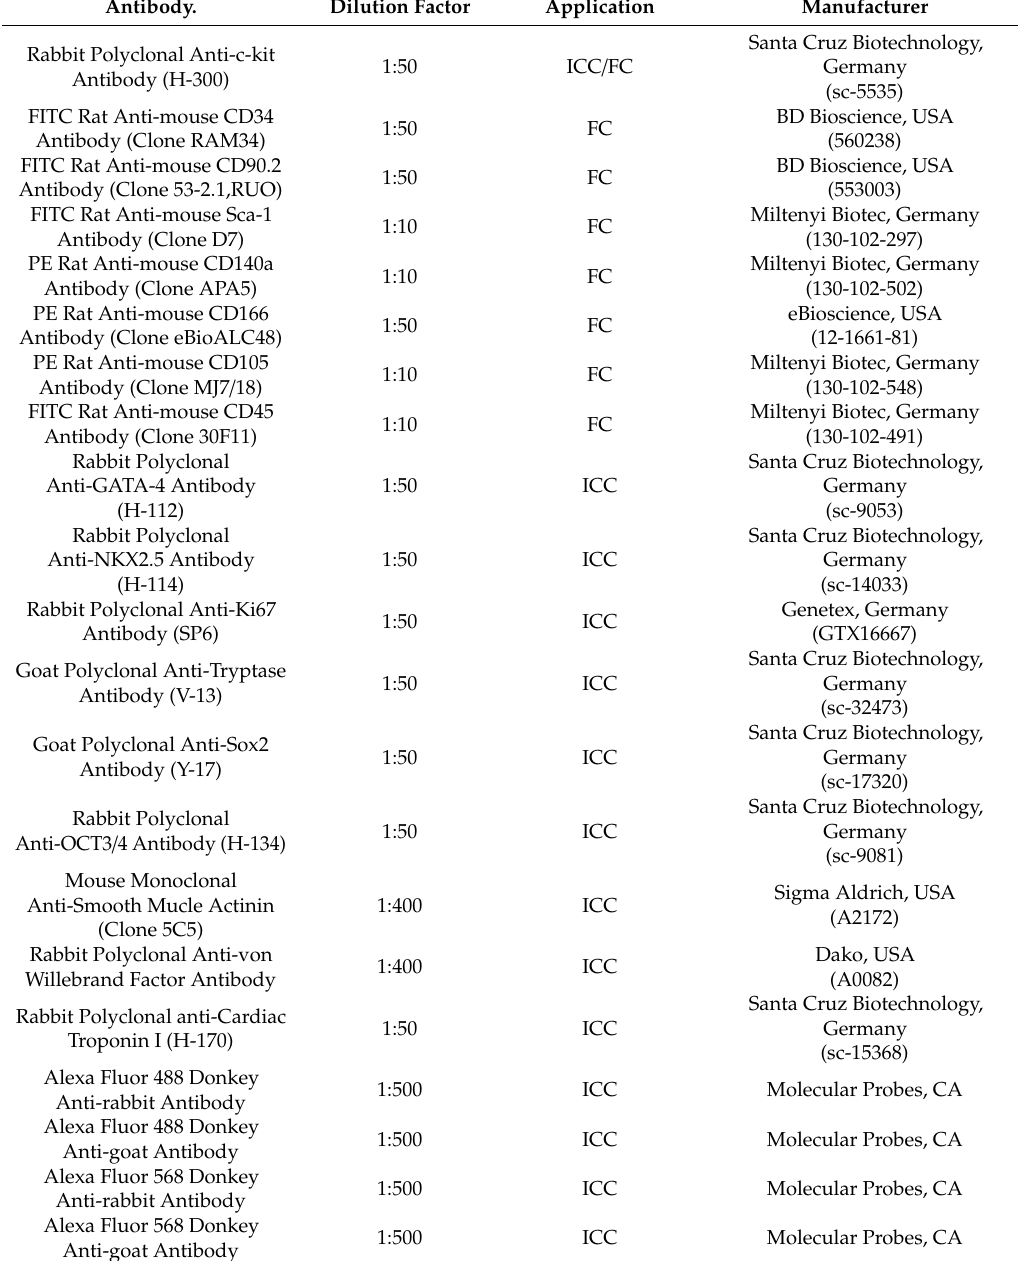
Table 1. List of antibodies for CC characterisation and di ff erentiation. Antibody. Dilution Factor Application